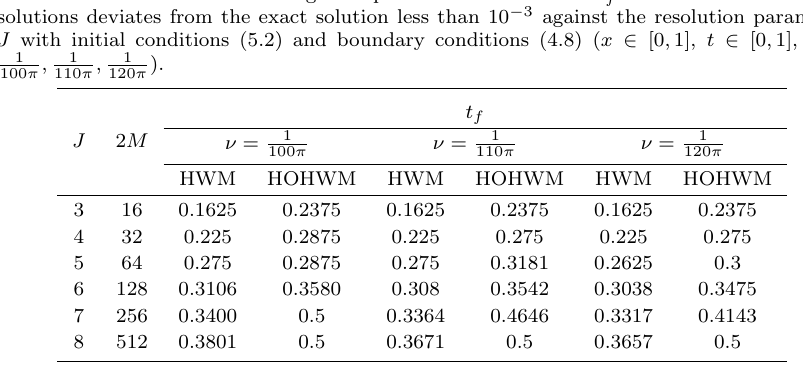
The Burgers’ equation was solved for diffusion coefficient values of ν =